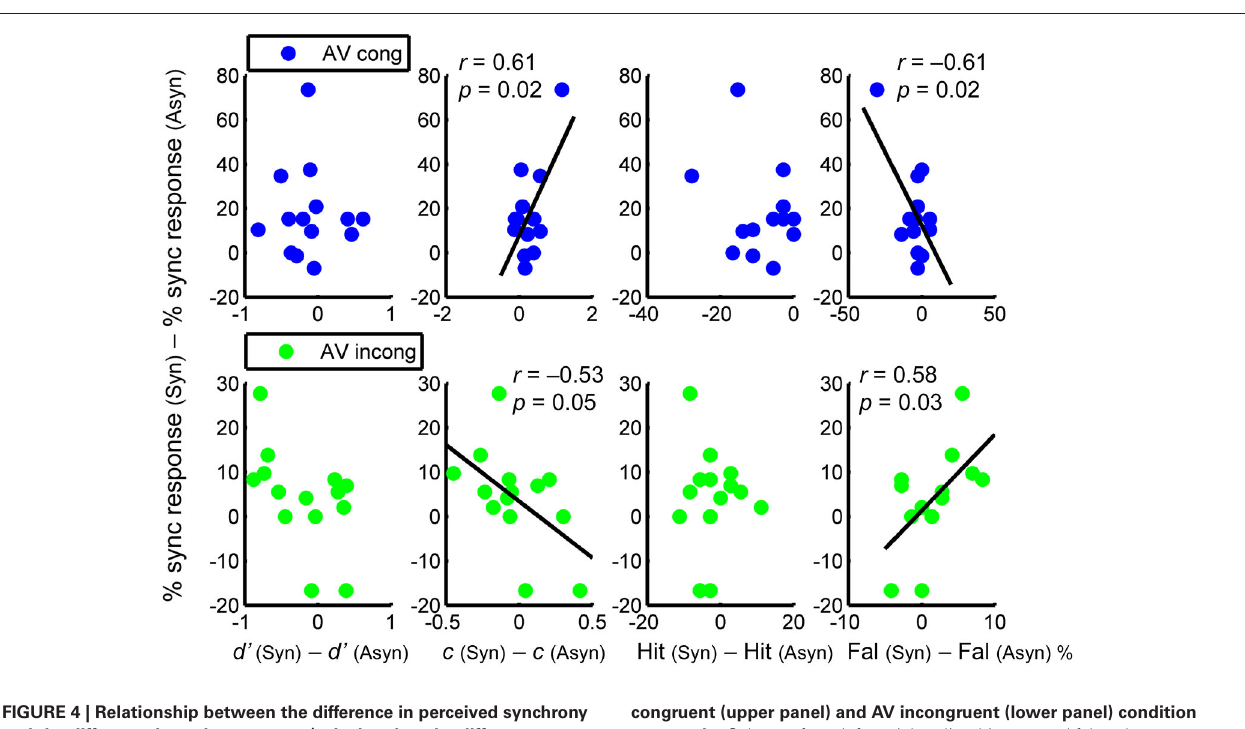
FIGURE 4 | Relationship between the difference in perceived synchrony and the difference in each parameter (calculated as the difference between AV synchronous and asynchronous conditions), for AV